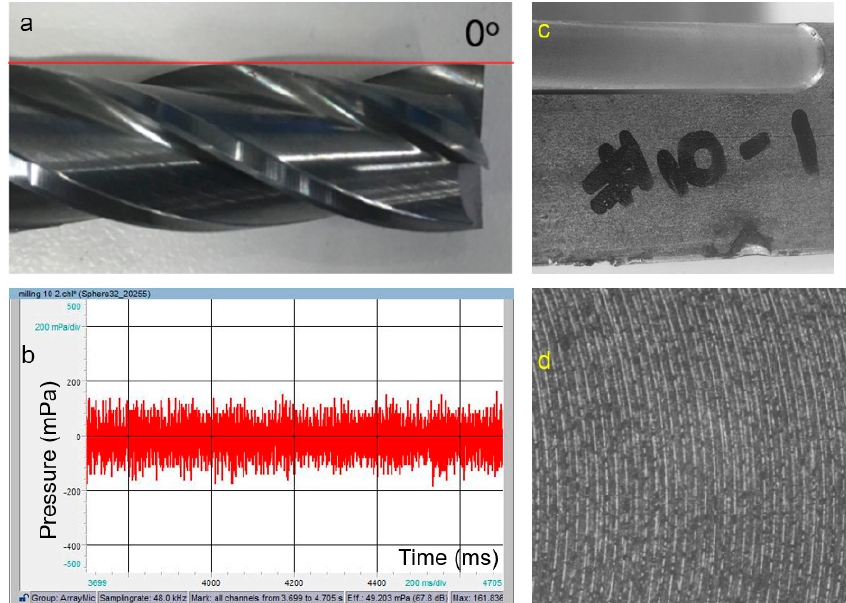
Figure 8. Acoustic and surface measurement for Tool 10 during milling: ( a ) image of tool with wear condition; ( b ) noise emission during load (Feed = 3 in/min; depth of cut = 0.05 in and RPM = 750); ( c ) milled piece; and ( d ) image on surface roughness.